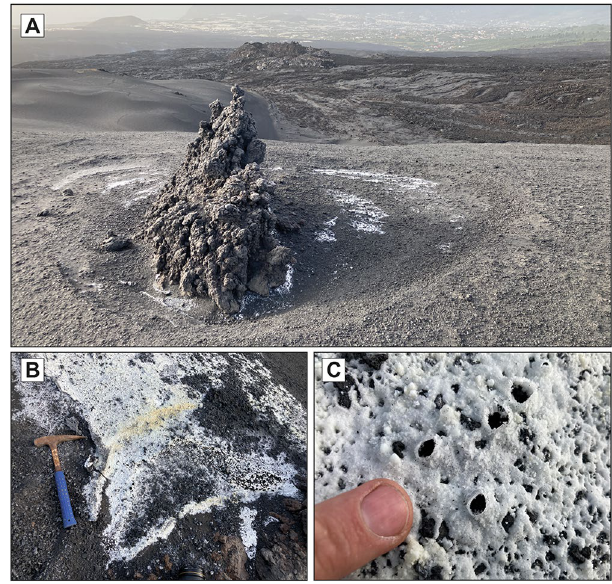
Figure 3. Efflorescent patches associated with the Tajogaite fumaroles located in distal areas of the main craters. ( A ) Whitish patches associated with erratic block porosity, defining a typical concentric distribution. Sampling point 6 (Fig. 2). ( B ) Fumarolic whitish mineralization, mainly composed of carbonates and hydrated sulphates. Sampling point 2 (Fig. 2). ( C ) Detail of image B showing cylindrical microstructures related to gas